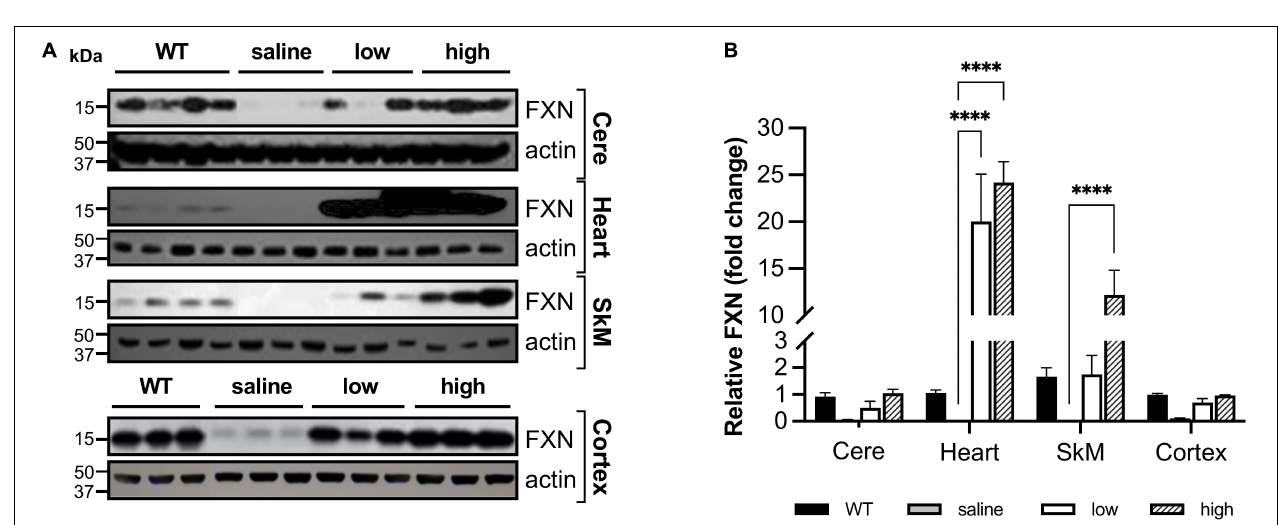
FIGURE 9 | AAV8-m FXN gene therapy partially reverses reduced survival and weight loss in FRDAkd mice. (A) Experimental paradigm of gene therapy (AAV8-m FXN ) treatment in 3-month-old FRDAkd mice. Doxycycline treatment started at week “0” and continued to week 22 (except PGK high which had early termination because they died after 15_weeks on dox/5 weeks after AAV8). All groups received AAV8 10 weeks post doxycycline treatment and rotarod testing was performed at weeks 6, 10, 14, 18, and 22 post dox treatment. (B) Survival rate, (C) animal weight and (D) rotarod analysis of AAV8-m FXN treated FRDAkd mice and controls. WT = wild-type, TG- = transgenic no dox treatment, PGK High = transgenic mice with dox treatment and 3.00E + 14 vg/kg AAV8, PGK Half = transgenic mice with dox treatment and 0.5 E + 14 vg/kg AAV8, PGK Low = transgenic mice with dox treatment and1.00E + 14 vg/kg dose AAV8, placebo = transgenic mice with dox treatment and placebo (Lactated Ringer’s Solution w/10% Poloxamer) [Stats: WT, n = 32, TG-, n = 13, TG- placebo n = 6, TG + PGK high, n = 9, TG + PGK low n = 9, Two-way repeated-measures ANOVA with Tukey’s post hoc for panels (B,C) , P values on Tables 3 , 4 ].